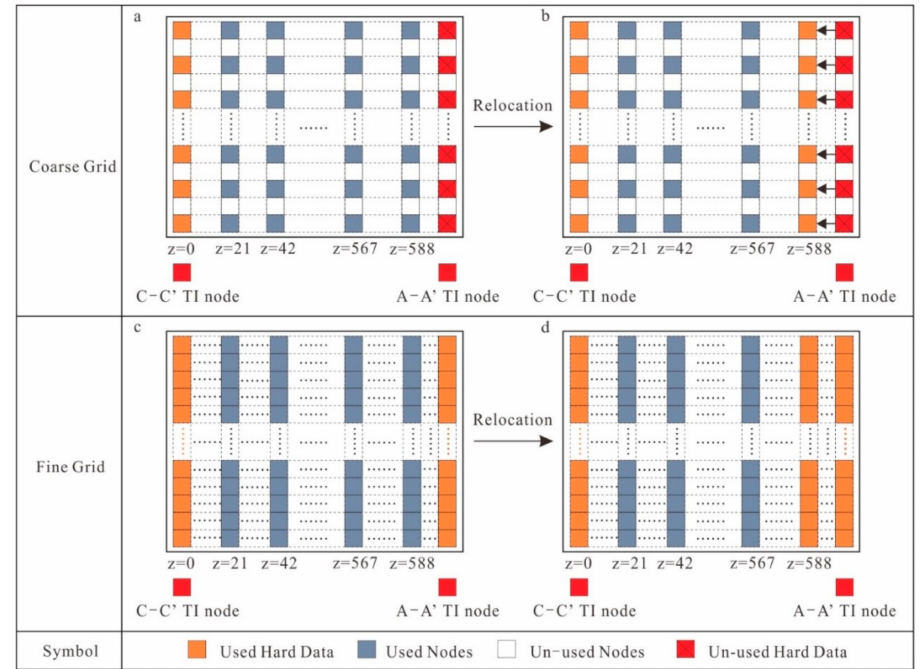
Figure 7. Illustration of conditioning data relocation in the multiple-grids setting. ( a , c ) The utilization of conditioning data in the original condition; ( b , d ) the utilization of conditioning data under